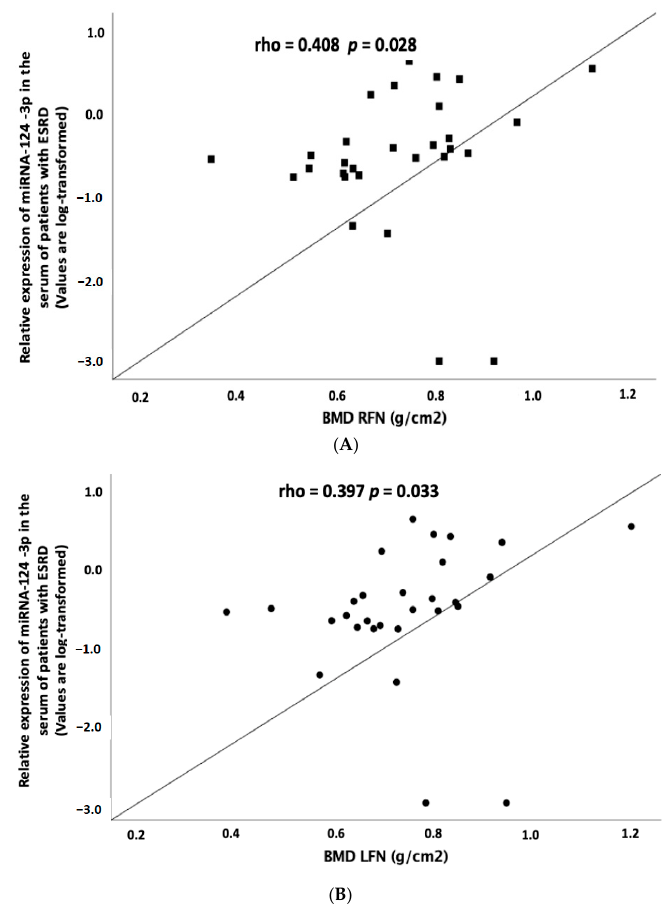
Figure 2. Correlation of the relative expression of miRNA-124-3p in the serum of ESRD patients on hemodialysis (HD) (cases) with ( A ) BMD in RFN and ( B ) BMD in LFN. The relative expression of miRNA-124-3p is log transformed. BMD, bone mineral density; LFN, left femoral neck; RFN, right femoral neck; ESRD, end-stage renal disease; miRNA, microRNA